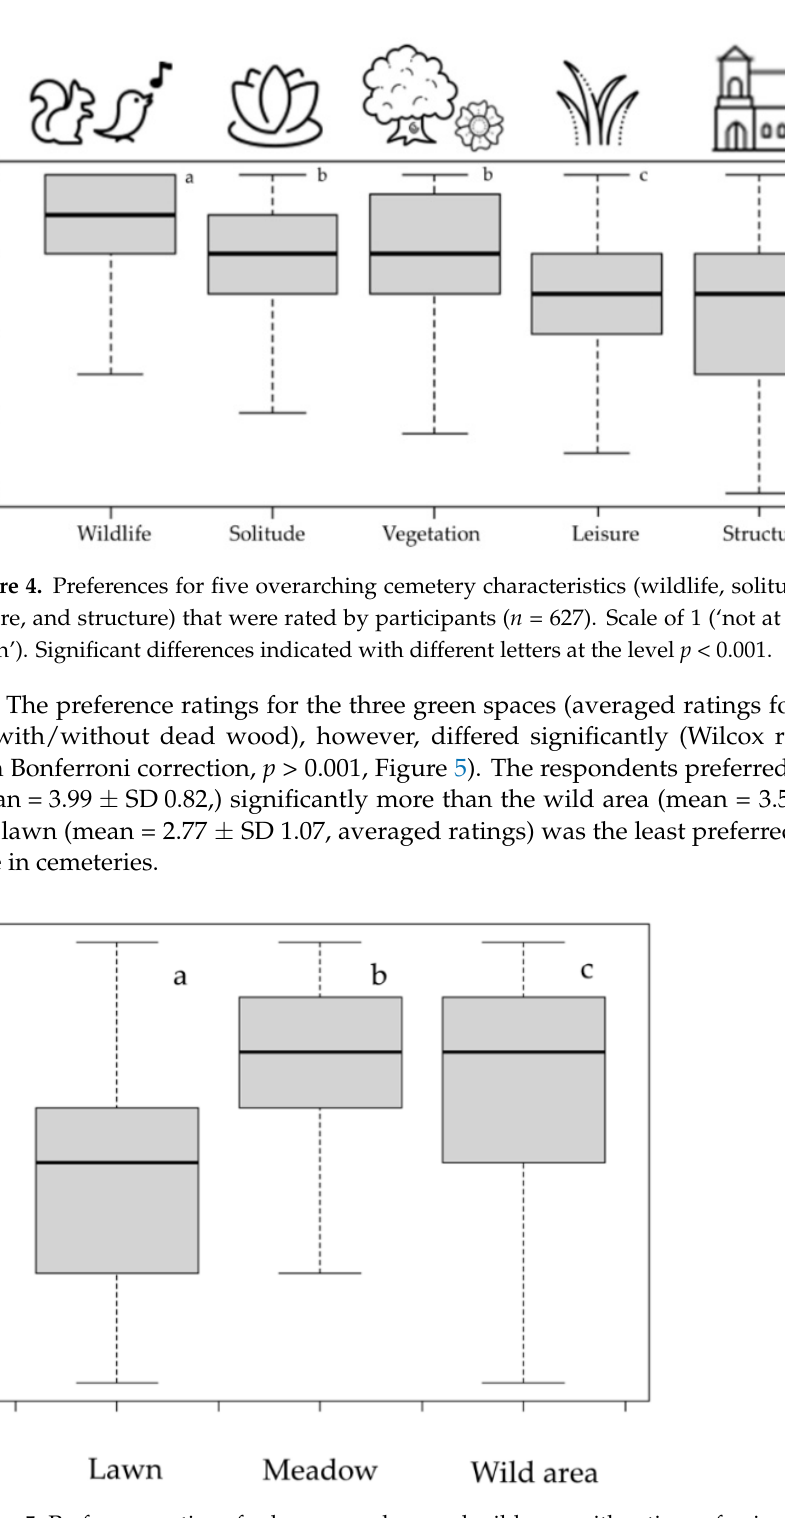
Figure 3. Items within each cemetery characteristic category (from most to least preferred). Procen-